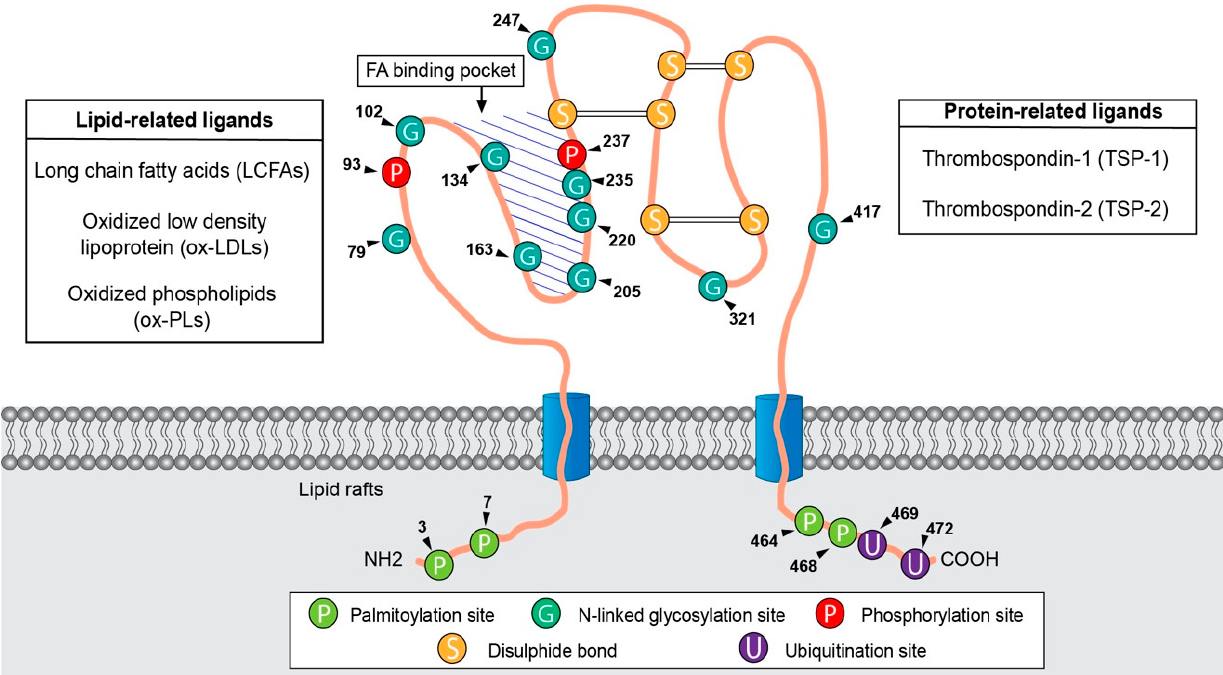
Figure 1. Schematic presentation of the CD36 structure. CD36 harbours two transmembrane domains in a large extracellular region containing ligand-binding sites. CD36 has two cytoplasmic tails (N-terminal and C-terminal) that contains four palmitoylation sites. The C-terminus contains two ubiquitination sites. The large extracellular loop contains 10 N-linked glycosylation sites and two phosphorylation sites. CD36 also contains three disulphide bonds between extracellular cysteines. In addition, the hydrophobic pocket is involved in ligand binding and serves as a tunnel through which hydrophobic ligands are transported from the extracellular space across the phospholipid membrane bilayer. Arrowhead and numbers denote the approximate position of amino acid